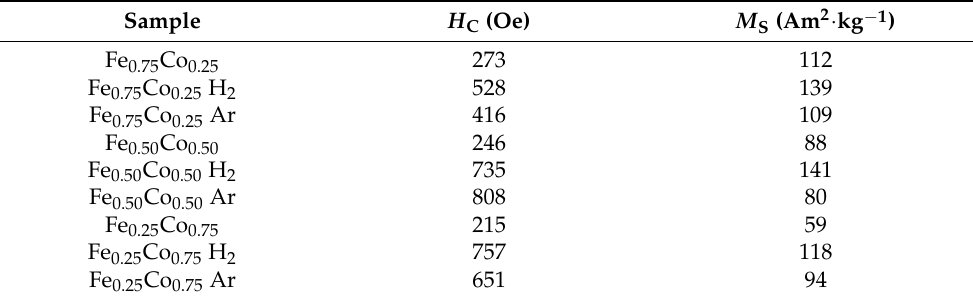
Table 4. Coercivity ( H C ) and saturation magnetization ( M S ) of as-prepared and annealed Fe-Co nanochains determined during the room temperature magnetic